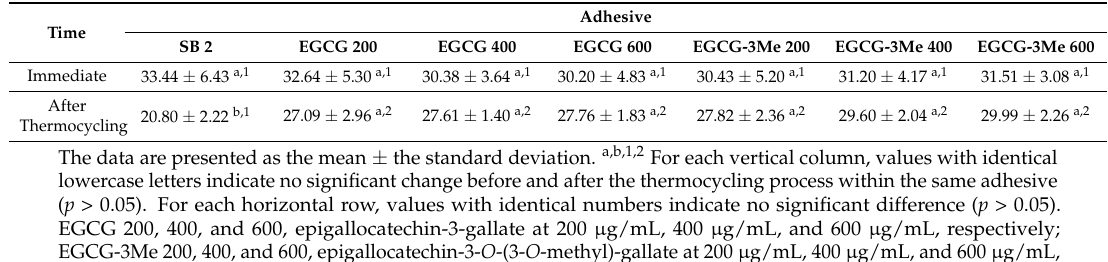
Table 3. Microtensile bond strength